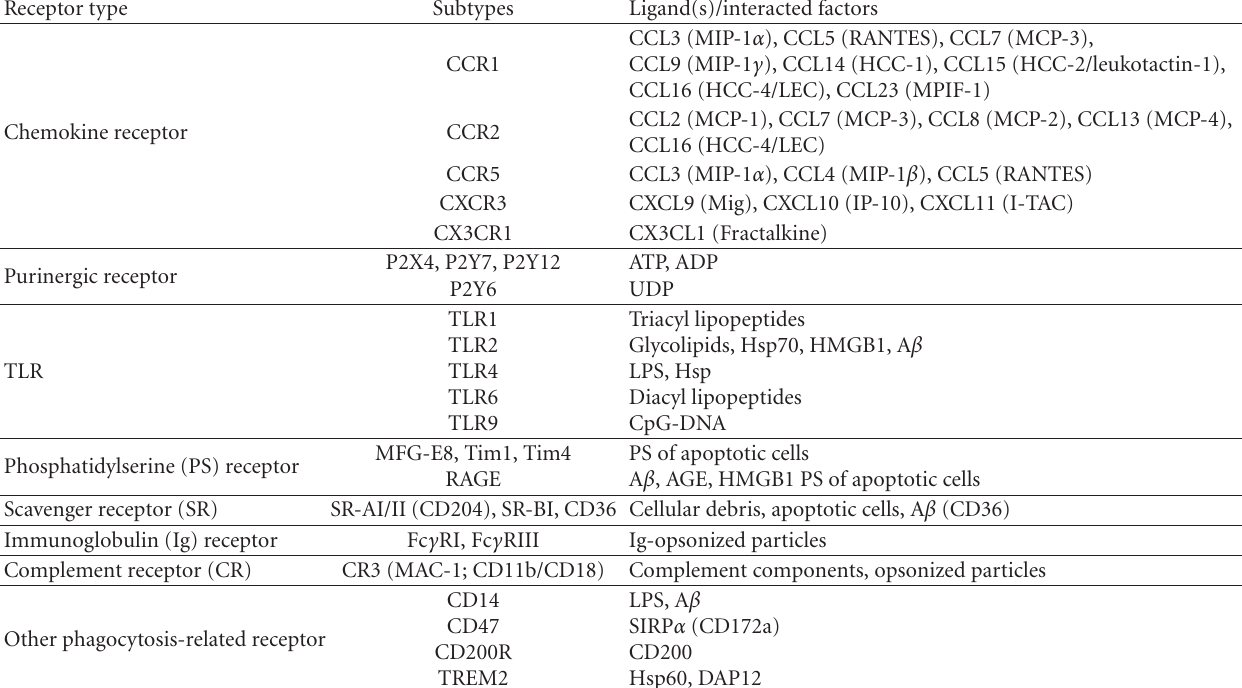
Table 1: Various chemotaxis or phagocytosis-related receptors in microglia and its ligand(s) or interacted factors. Microglia are activated with various stimuli through the specific receptor of each stimuli. For detailed review of chemokines, pathogens, and factors associated with tissue damage recognized by microglia, refer to